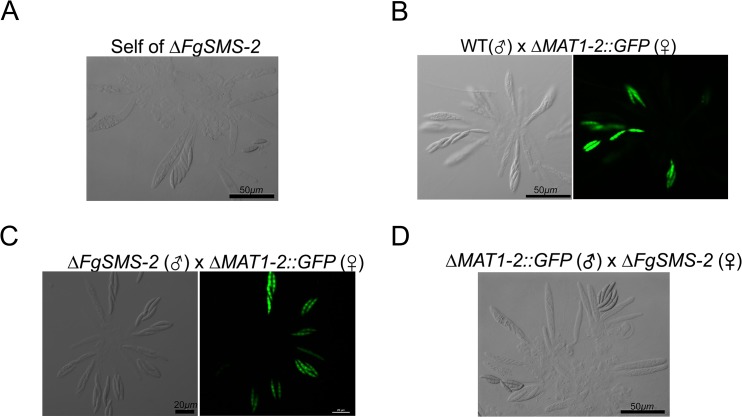
Morphology of asci and ascospores produced in the self-cross of ΔFgSMS-2 (A) and outcrosses between WT(♂) and ΔMAT1-2::GFP(♀) (B), between ΔFgSMS-2(♂) and ΔMAT1-2::GFP(♀) (C), and between ΔMAT1-2::GFP(♂) and ΔFgSMS-2(♀) (D).WT, the self-fertile F. graminearum wild-type Z3643 strain; ΔFgSMS-2, a transgenic Z3643 strain lacking the FgSMS-2 gene; ΔMAT1-2::GFP, a self-sterile transgenic Z3643 strain where the MAT1-2 locus was replaced with a green fluorescence protein gene (GFP). For the outcrosses, the mycelia of strain acting as a female (♀) were spermatized with conidia of a male-acting strain (♂), as described previously [11]. Only four out of eight ascospores in each ascus fluoresced, as observed by confocal laser microscopy in the outcross between wild-type and ΔMAT2::GFP (B), whereas the outcross of ΔFgSMS-2 to ΔMAT1-2::GFP (C) produced incomplete tetrads, in which the GFP marker did not segregate equally.